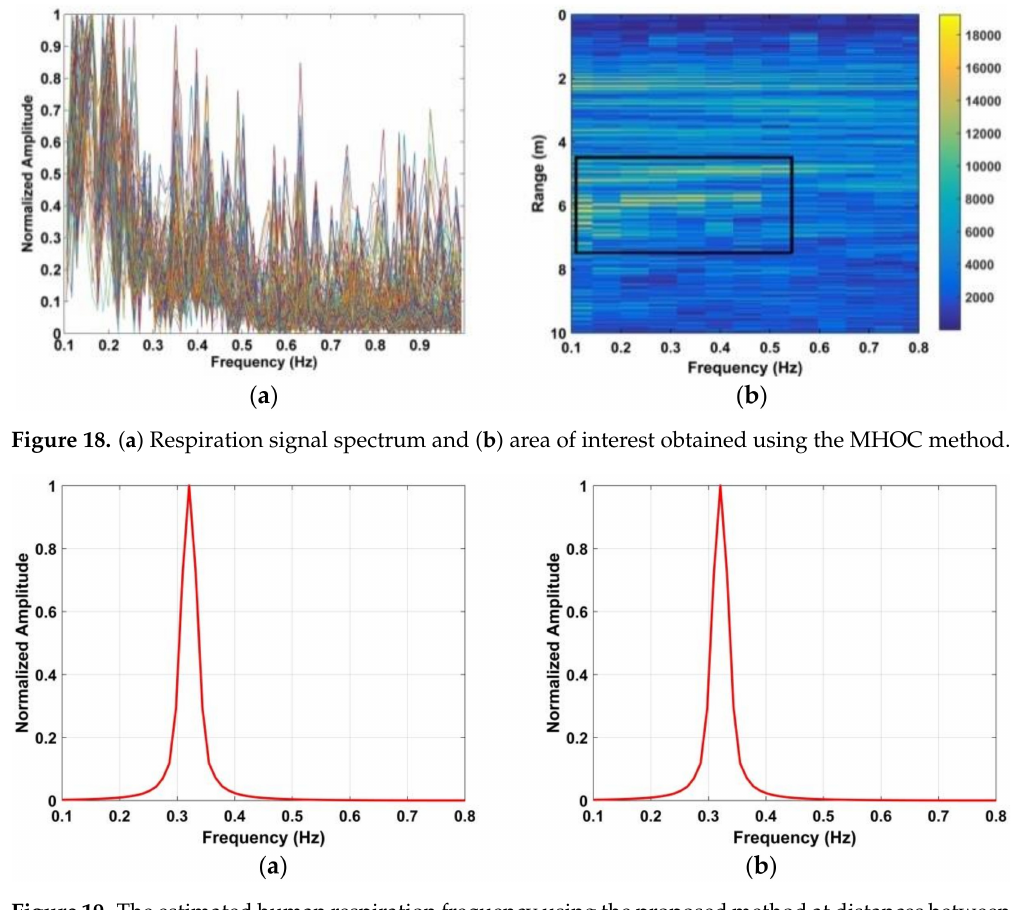
Figure 19. The estimated human respiration frequency using the proposed method at distances between the antenna and human subject of ( a ) 900 cm, and ( b ) 1100